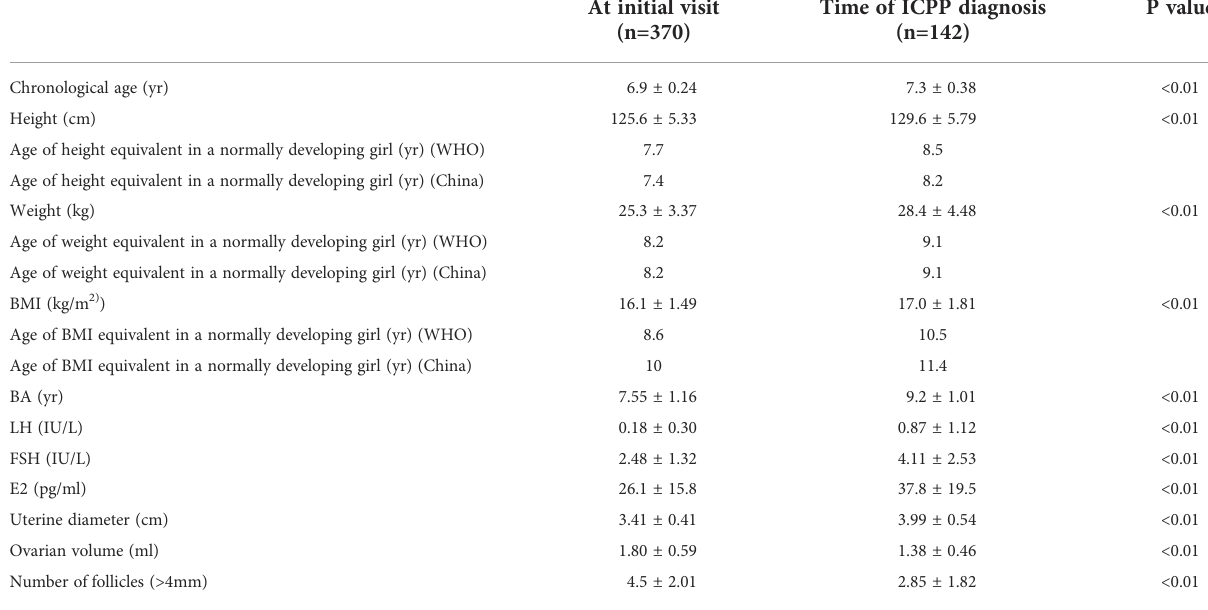
TABLE 3 Physical and sexual development at the initial visit and the time of CPP diagnosis in girls with early breast development.